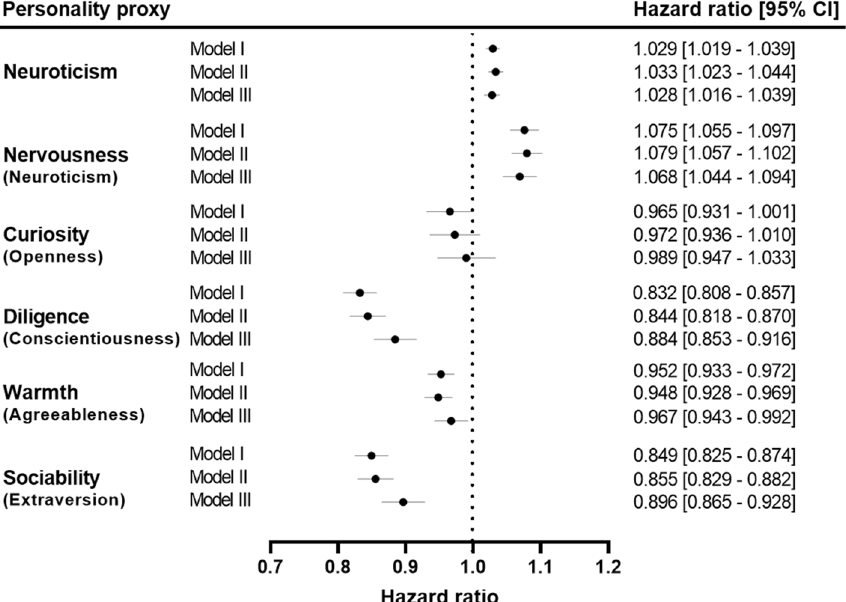
Figure 3. Association of neuroticism and personality trait proxies with incident myocardial infarction. Labels in small brackets represent original Big Five personality trait corresponding to each personality trait proxy. Model I: analyses were adjusted for demographic factors (sex, age, Townsend Deprivation Index and ethnic background). Model II: analyses were adjusted for health-related measures (body mass index, systolic blood pressure, diastolic blood pressure and diabetes) in addition to demographic factors. Model III (or fully adjusted model): analyses were adjusted for lifestyle factors (alcohol intake frequency, smoking status, and physical activity) in addition to demographic factors and health-related measures. The plot was created using GraphPad Prism